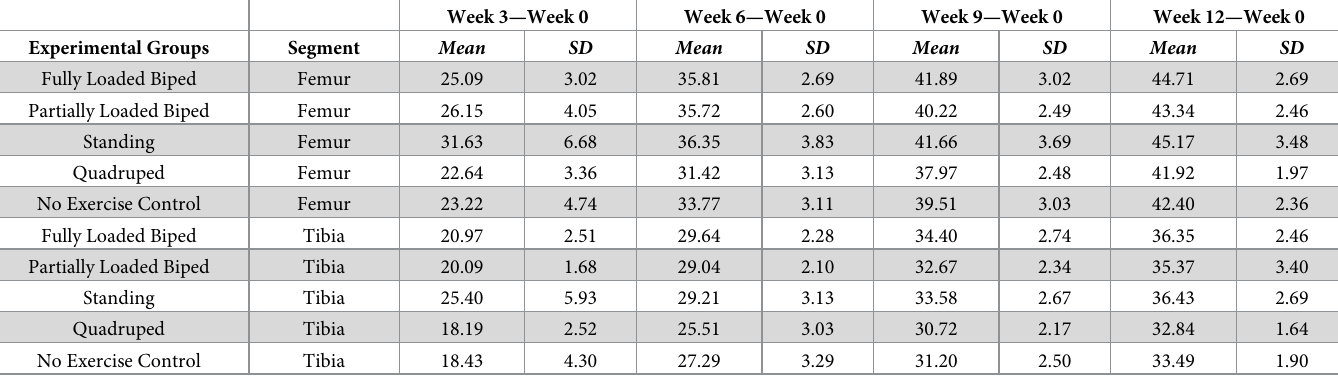
Table 4. Mean percentage differences in femur and tibia lengths by group.